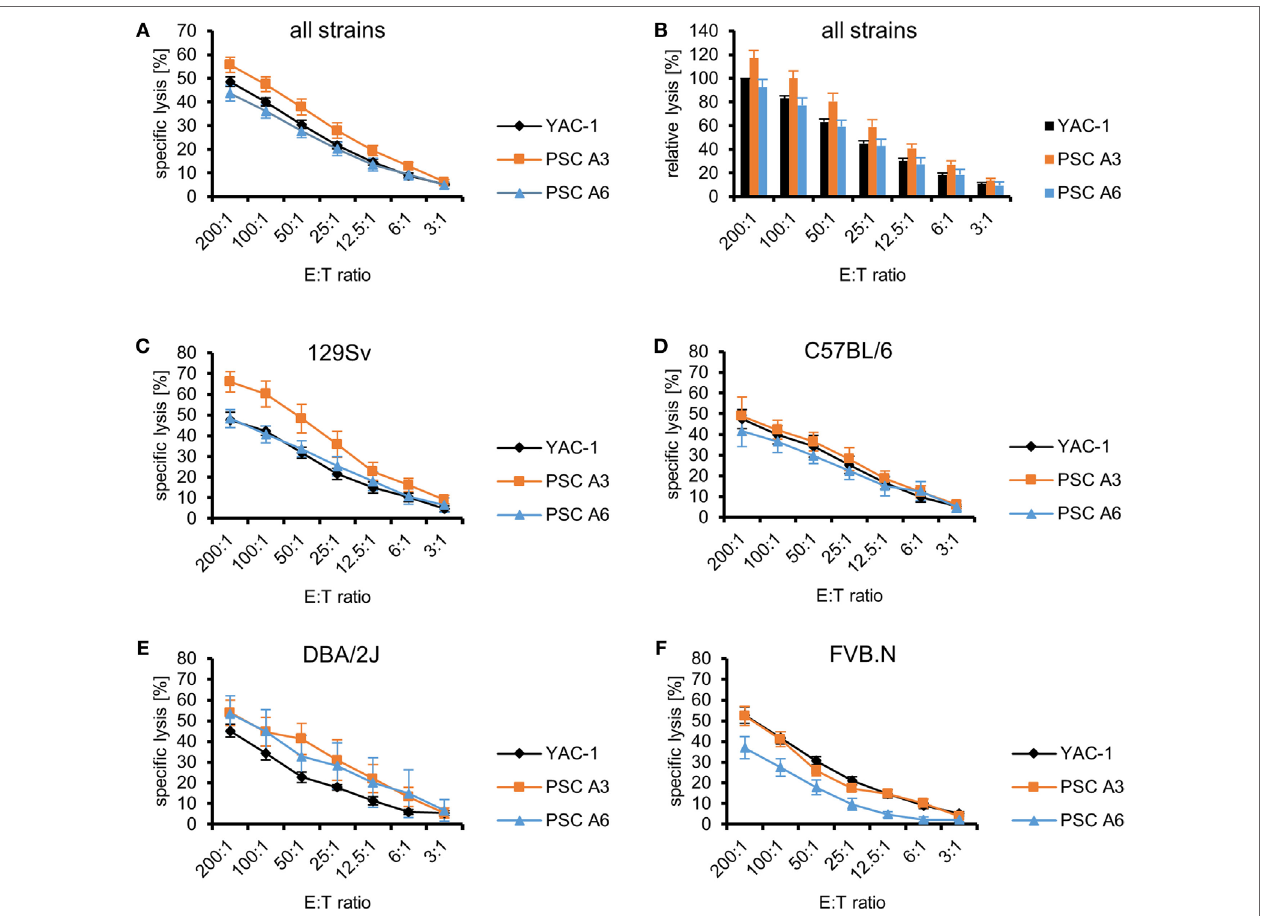
FigUre 1 | Comparison of the killing of parthenogenetic stem cell (PSC) A3, PSC A6, and YAC-1 target cells by lymphokine-activated killer (LAK) cells of four mouse strains. (a) A summary of means of specific lysis and the SEM is shown as determined by 51 Cr-release assays of the three target cell lines YAC-1 ( n = 38), PSC A3 ( n = 18), and PSC A6 ( n = 20) using LAK cells from four mouse strains (129Sv, n = 10; C57BL/6, n = 10; DBA/2J, n = 7; FVB.N, n = 11). (B) The data are shown as relative lysis calculated by setting the specific lysis of YAC-1 cells at the highest effector to target (E:T) ratio (200:1) in individual experiments to 100% and adjusting the relative lysis at lower E:T ratios and of other target cells accordingly. (c) Summary of means of specific lysis and the SEM by LAK cells derived from 129Sv mice ( n = 10) of YAC-1 ( n = 10), PSC A3 ( n = 5), and PSC A6 cells ( n = 5). (D) Summary of means of specific lysis and the SEM by LAK cells derived from C57BL/6 mice ( n = 10) of YAC-1 ( n = 10), PSC A3 ( n = 4), and PSC A6 cells ( n = 6). (e) Summary of means of specific lysis and the SEM by LAK cells derived from DBA/2J mice ( n = 7) of YAC-1 ( n = 7), PSC A3 ( n = 4), and PSC A6 cells ( n = 3). (F) Summary of means of specific lysis and the SEM by LAK cells derived from FVB.N mice (